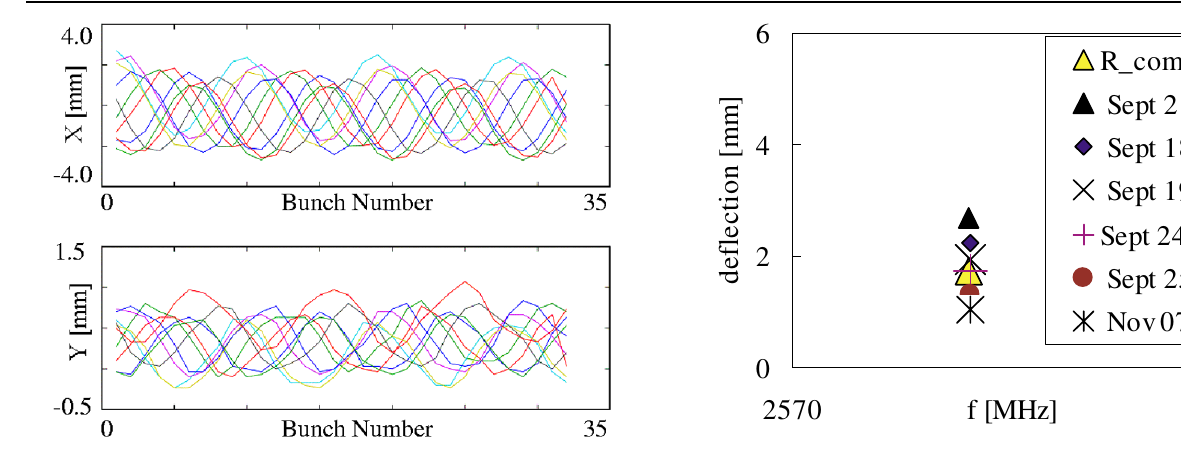
FIG. 10. (Color) BPM signals with the excitation of the deflect- ing dipole mode. Note different scales for both signals in the x plane.